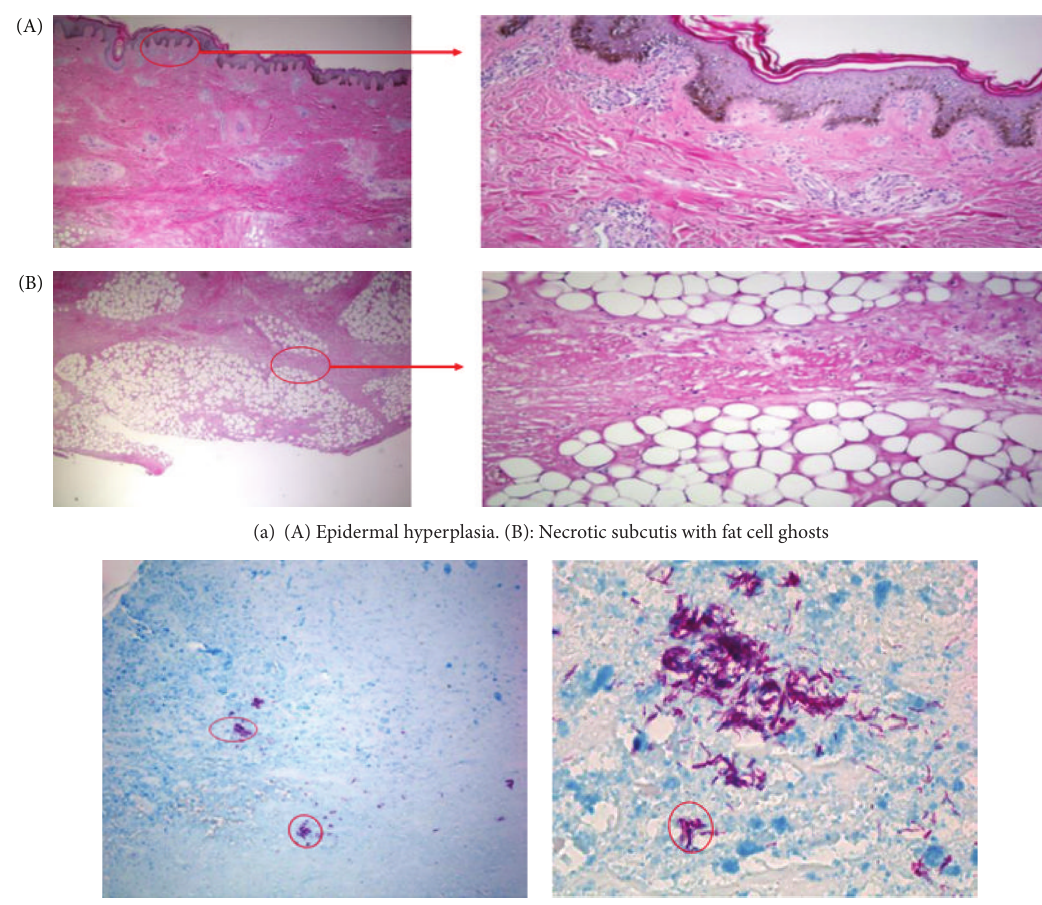
Figure 2: Histopathological images of Buruli ulcer